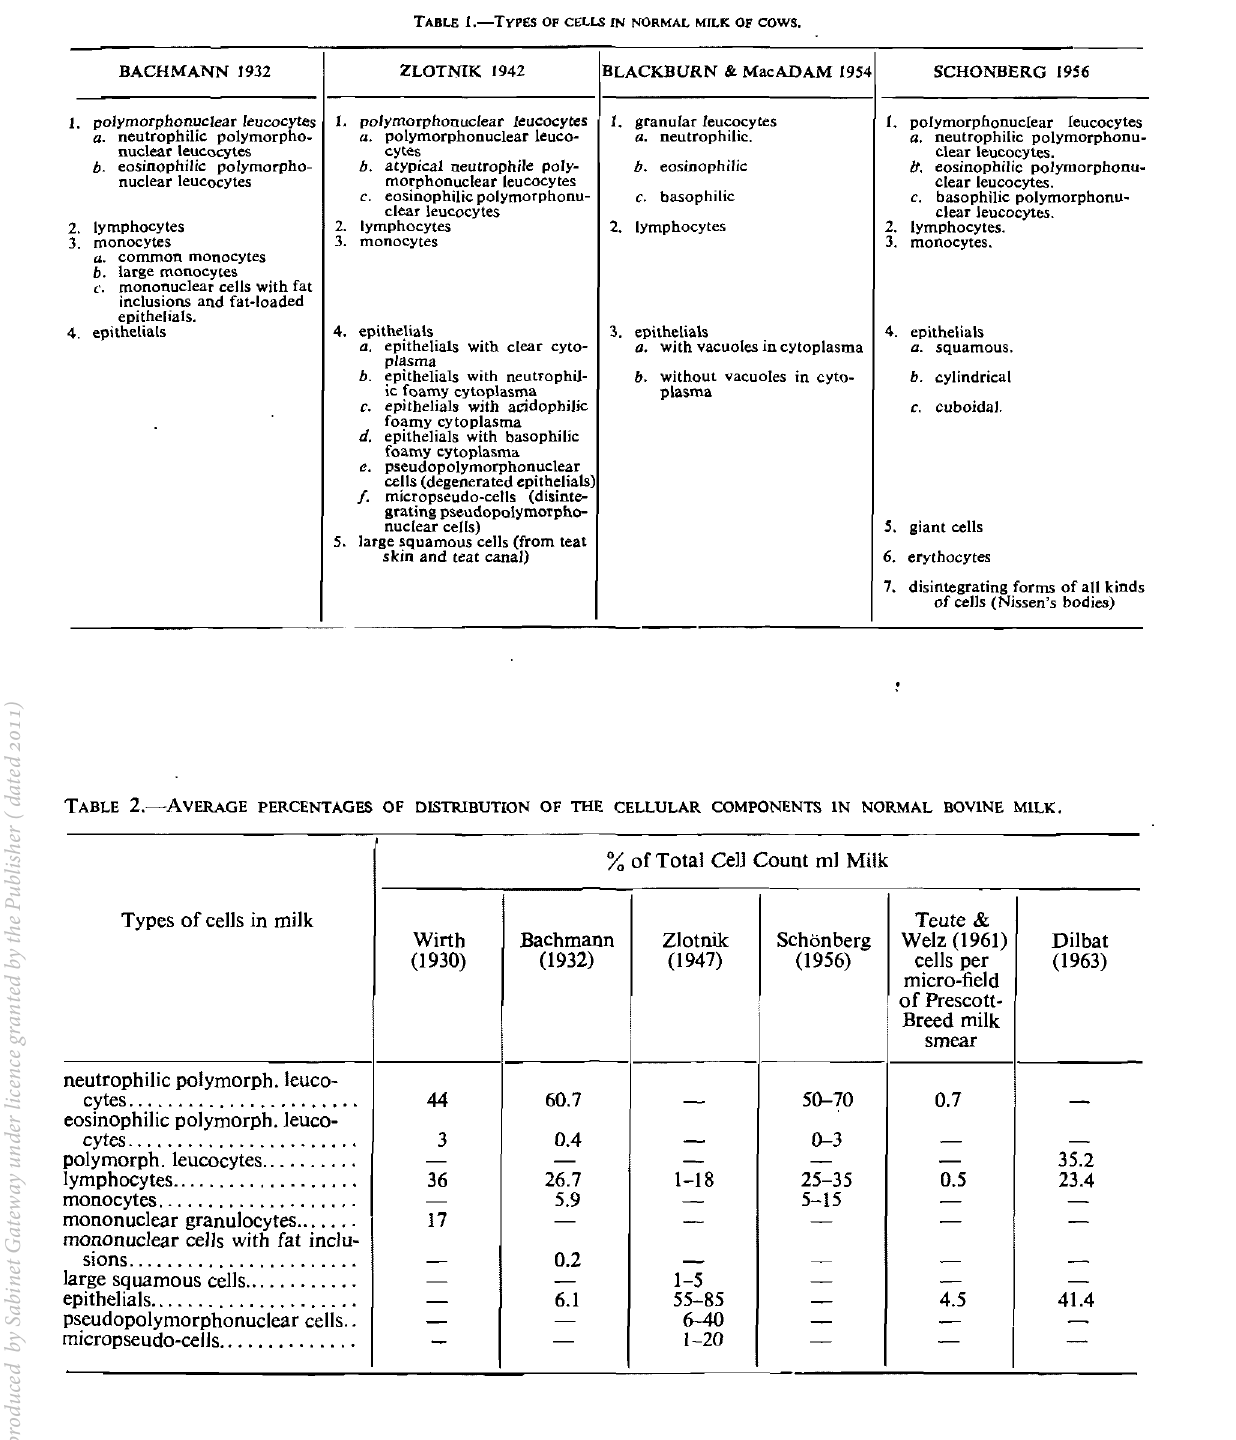
TABLE i.-TYPES OF CELLS IN NORMAL MILK OF COWS.